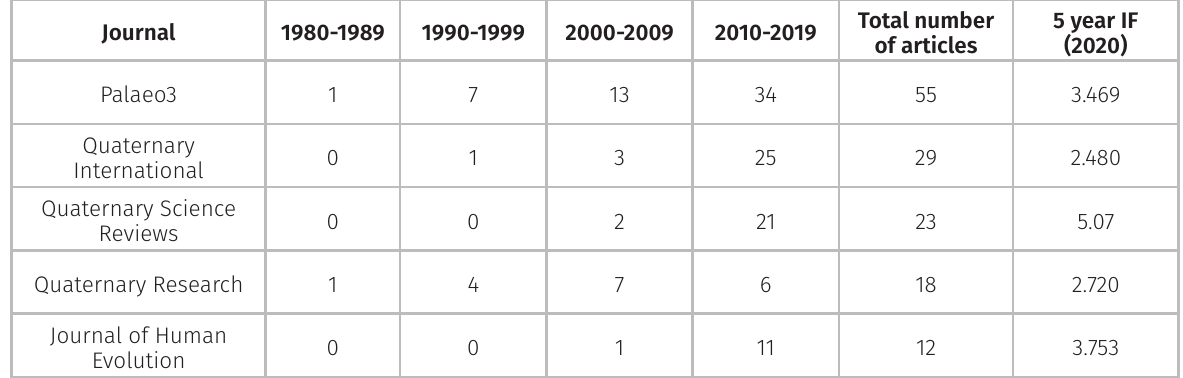
Table I. Top five journals with the largest number of publications in isotopic studies on Quaternary megafauna fossils, their respective number of articles published by decade, the totals for each journal and current five year impact factors